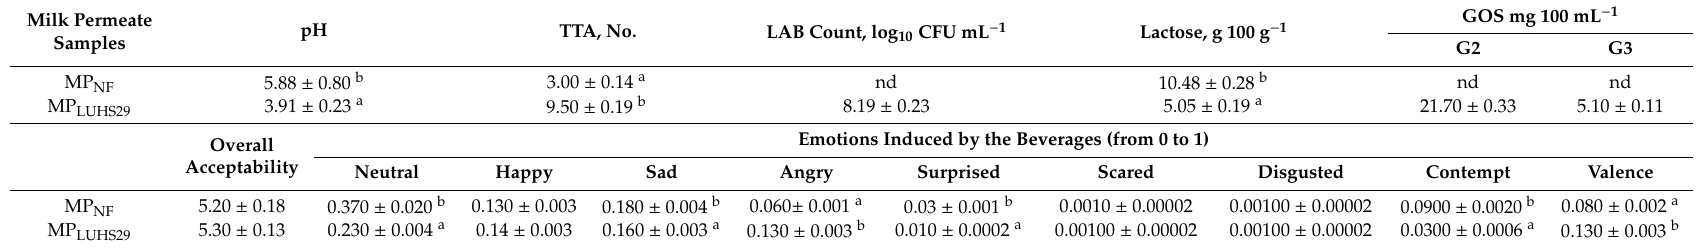
Table 1. Parameters after 48 h of milk permeate fermented with LUHS29 strain.